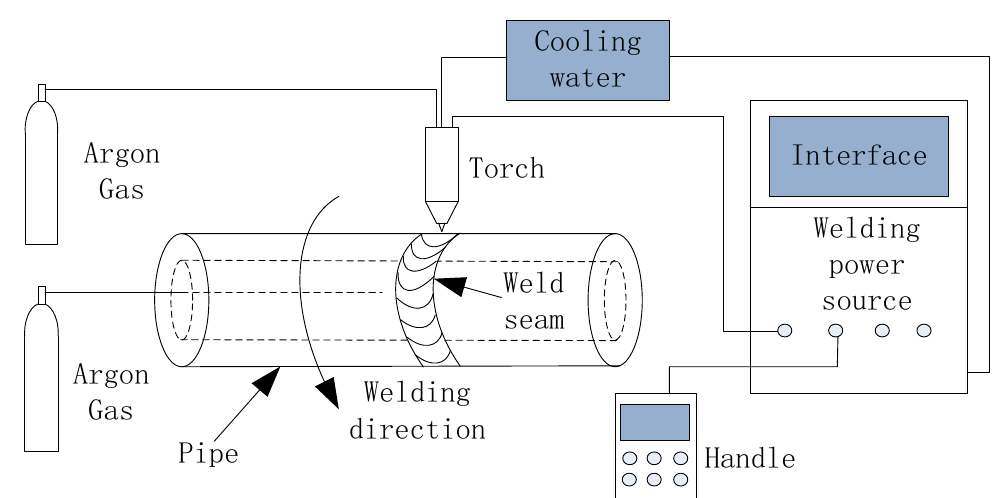
Figure 1. The schematic diagram of the system for all-position automatic tungsten inert gas (TIG) welding of pipes.